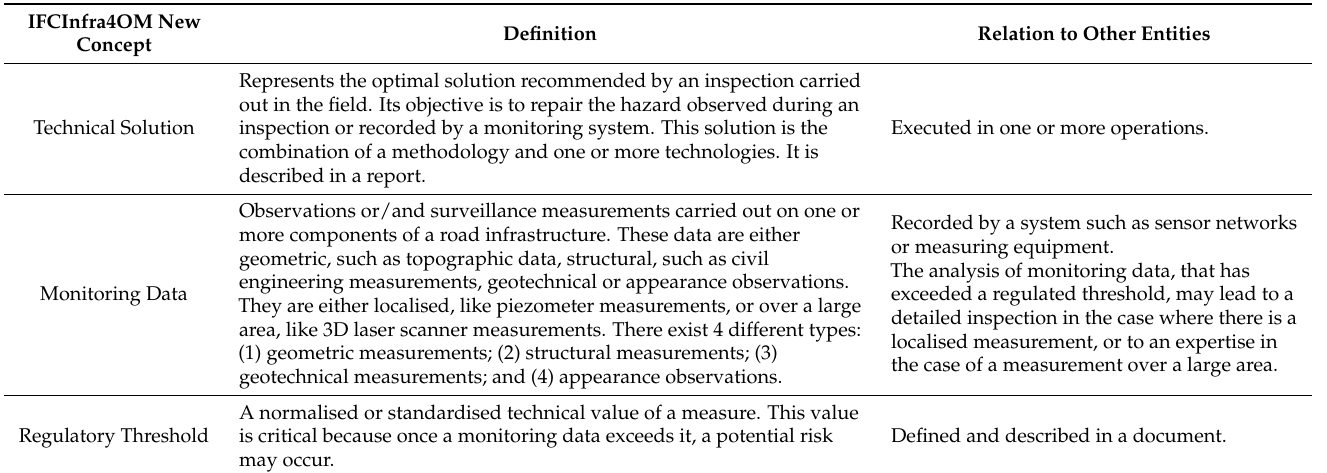
Table 5. Description of new IFCInfra4OM concepts to extend IFC